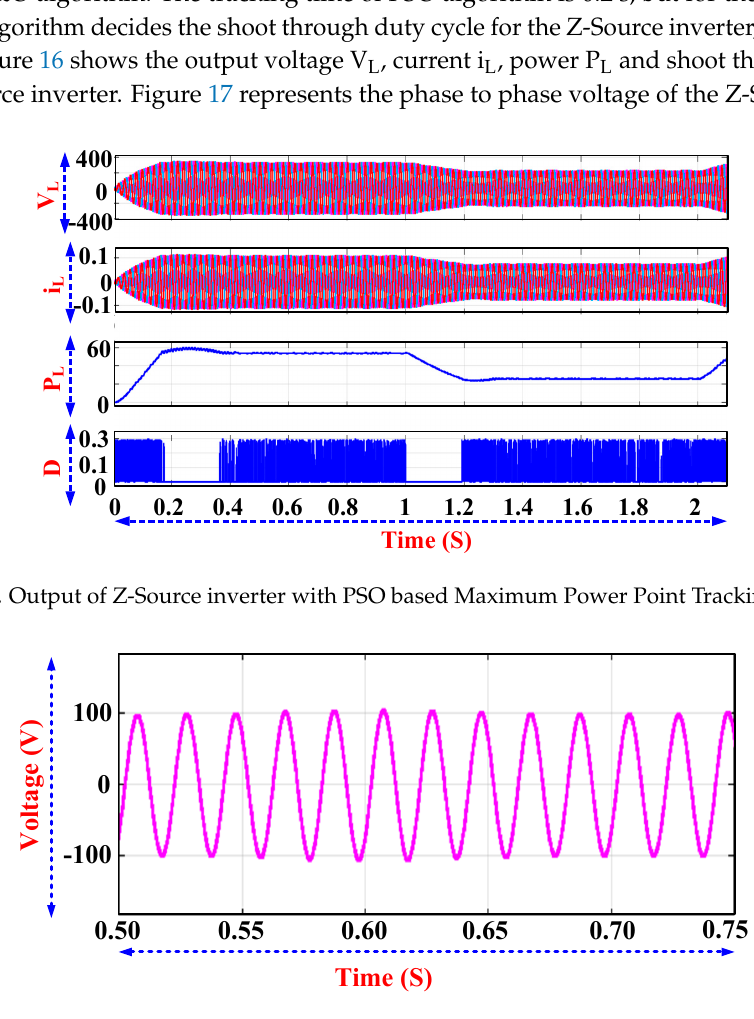
Figure 17. Phase to phase voltage of Z-Source inverter across resistive load.